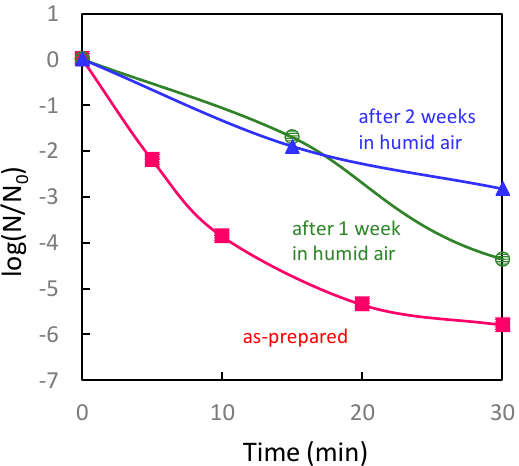
Figure 5. Antiviral properties of Cu 2 O after a week storage in 90% humid air atmosphere (green circles), those after two weeks storage in 90% humid air (blue triangles), and those of as-prepared sample using fresh Cu 2 O powder (FUJIFILM Wako Pure Chemical Corporation) taken from a commercial bottle (red squares). The data were based on averages of triplicate measurements for as-prepared sample, while duplicate measurements for 1 and 2 weeks after samples.